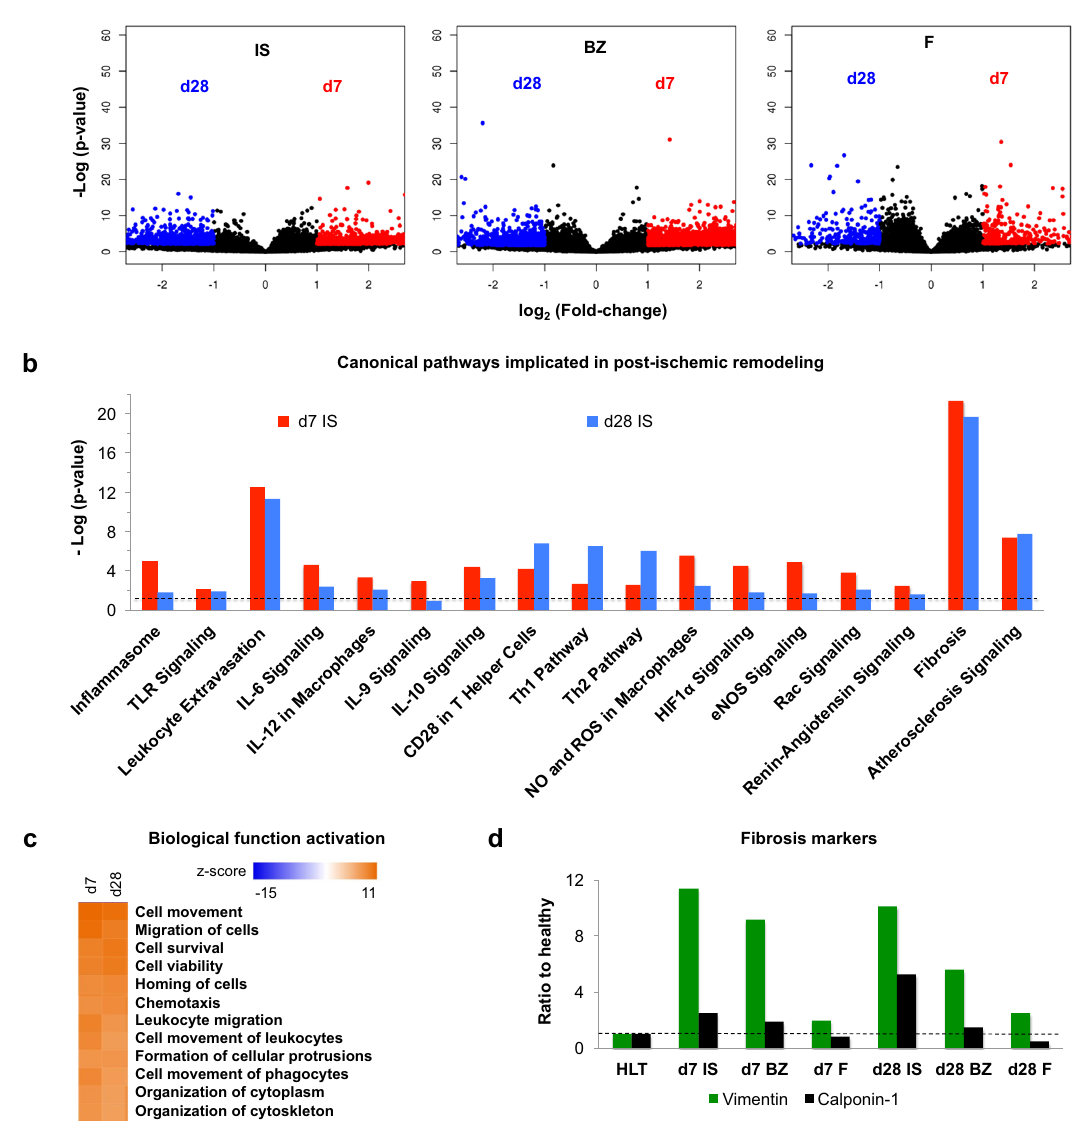
Fig. 3 | Post-ischaemic pathways alteration following NSTEMI. a Volcano plots showing the total genes signi fi cantly upregulated across the core ischaemic (IS), border (BZ) and remote (F) regions sampled on d7 and d28 post-NSTEMI. n =4 animalspergroup. b CanonicalPathwaysAnalysis(IPA®)ondifferentiallyexpressed genes (DEG) from RNA-seq data. Cut-offs of log 2 (fold-change) > 1.5 and log 2 (fold- change) < − 1.5, and adjusted- P <0.05 were set. Dashed line shows a threshold of -Log( p -value) of 1.3, corresponding to P =0.05. All DEG data were normalised to